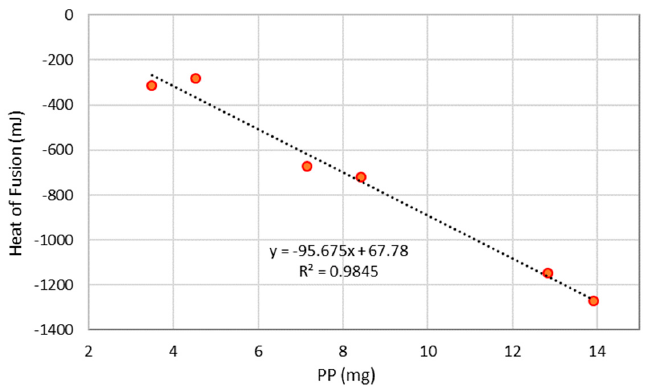
Table 4. TGA analysis on pure PP samples.